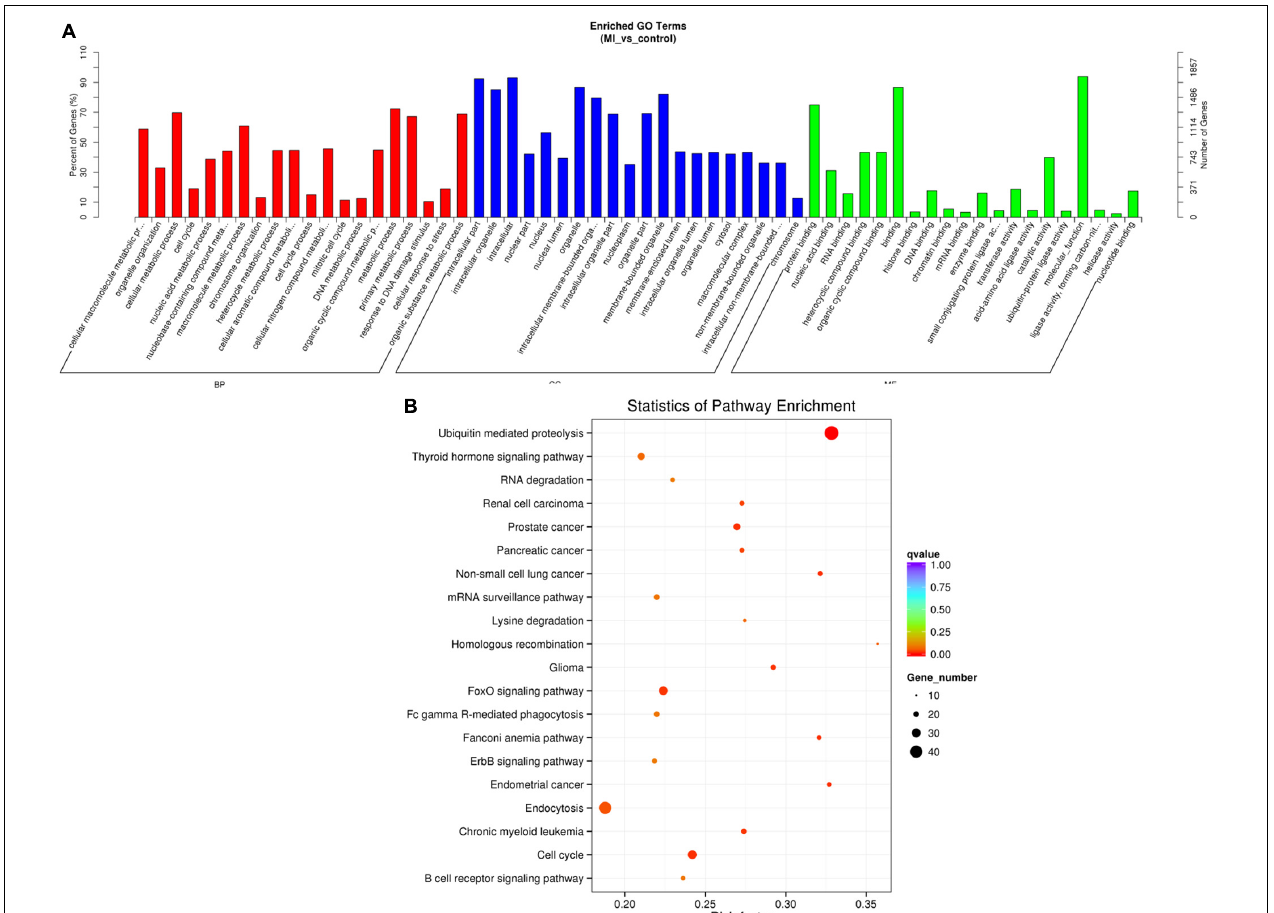
FIGURE 6 | GO and KEGG of differentially expressed circRNA genes. (A) GO analysis of differentially expressed circRNAs which covers 3 domains, namely, BP (red), CC (blue), and MF (green). Each domain contains the top 20 significantly enriched GO terms (29) and the top 20 significantly enriched pathways. (B) KEGG The y axis denotes the pathway, and the x axis denotes the rich factor. The size of the dots indicates the number of gene regulation in this pathway, and the colors of the dots correspond to different q -values. BP: biological process, CC: cellular component, MF: molecular function.